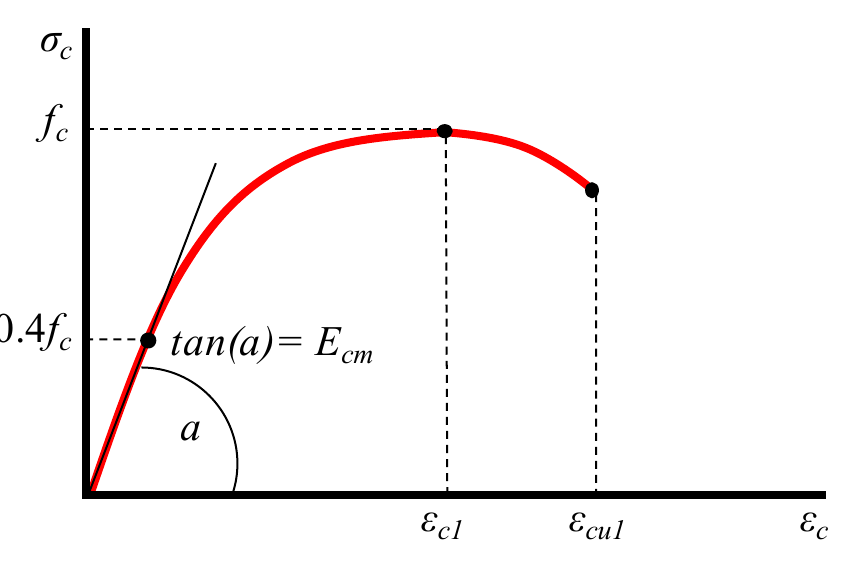
Figure 6. Stress-strain diagram of concrete under compression.